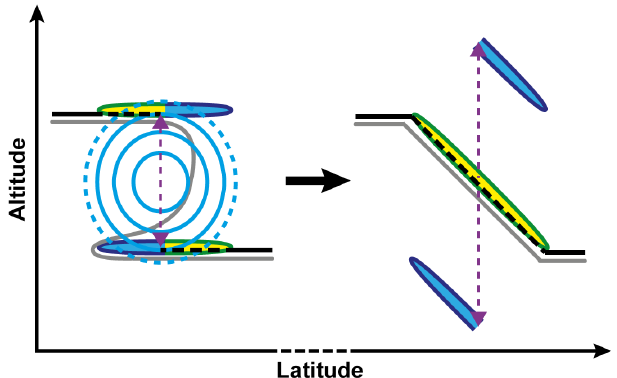
Figure 6. Schematical vertical cross section of the tropopause- based averaging method. Left part shows exemplary situation at the tropopause break, and right part the key measures after tropopause- based averaging. Black lines indicate the LRT, and grey lines the dynamic tropopause. Blue lines show isotachs, and the yellow and blue regions indicate regions of enhanced vertical wind shear above and below the jet